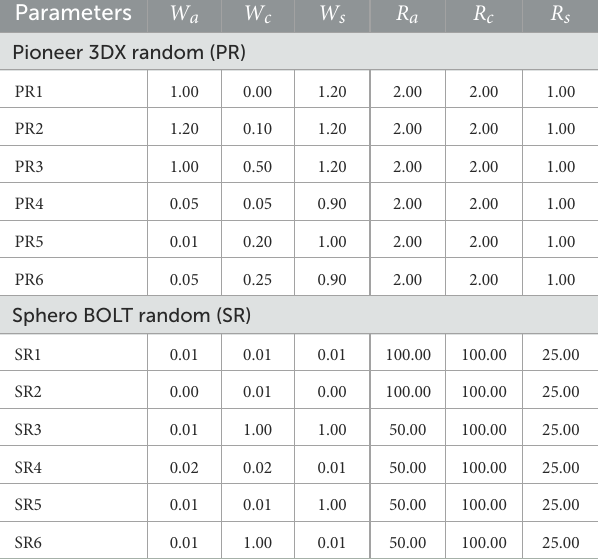
TABLE 1 Parameters for random behaviors of Pioneer 3DX robots (Abpeikar et al., 2022a) and Sphero BOLT robots.